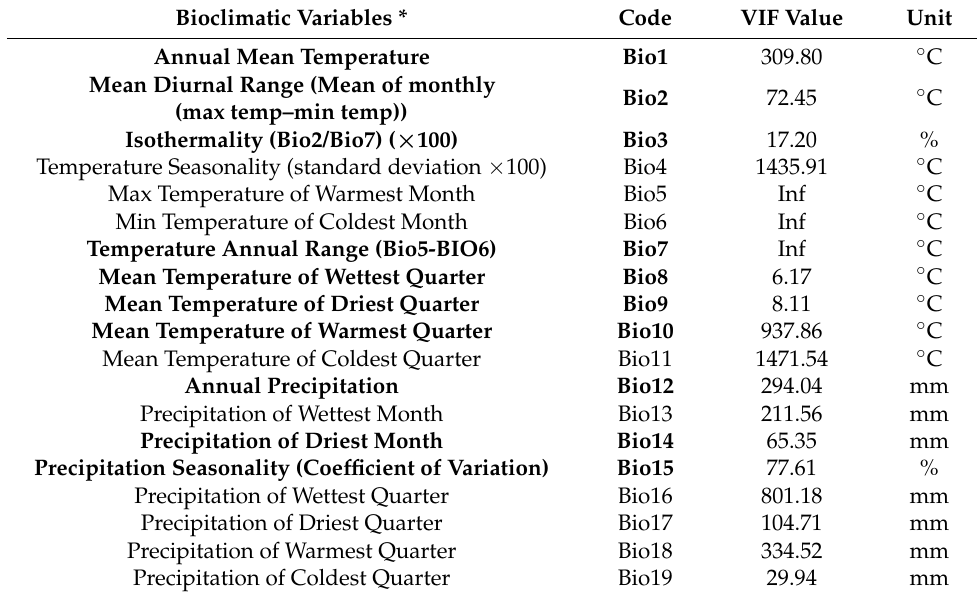
Table 1. The bioclimatic features, their codes, VIF values and